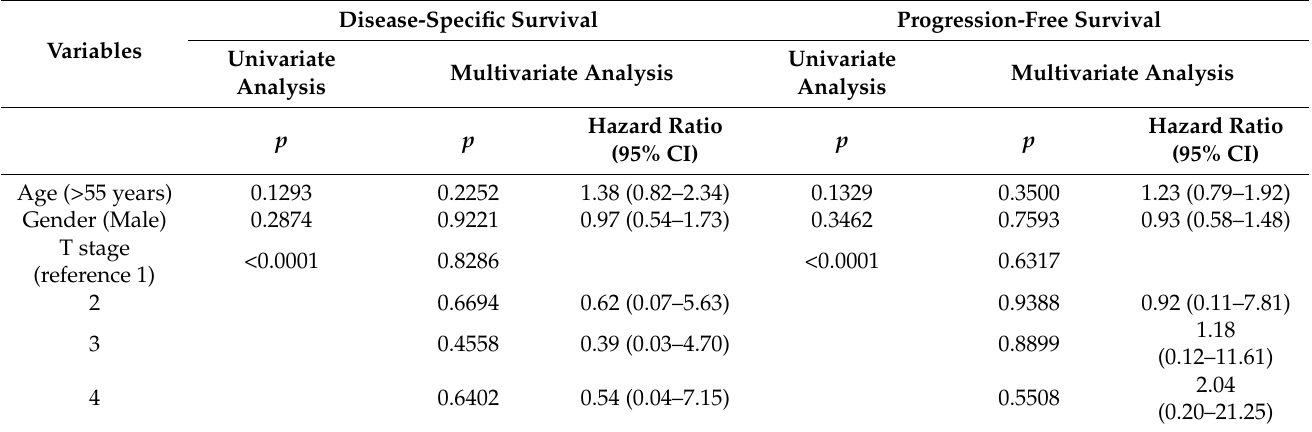
Table 5. Survival analysis of patients with oral squamous cell carcinoma according to clinicopatho- logic parameters and systemic inflammatory